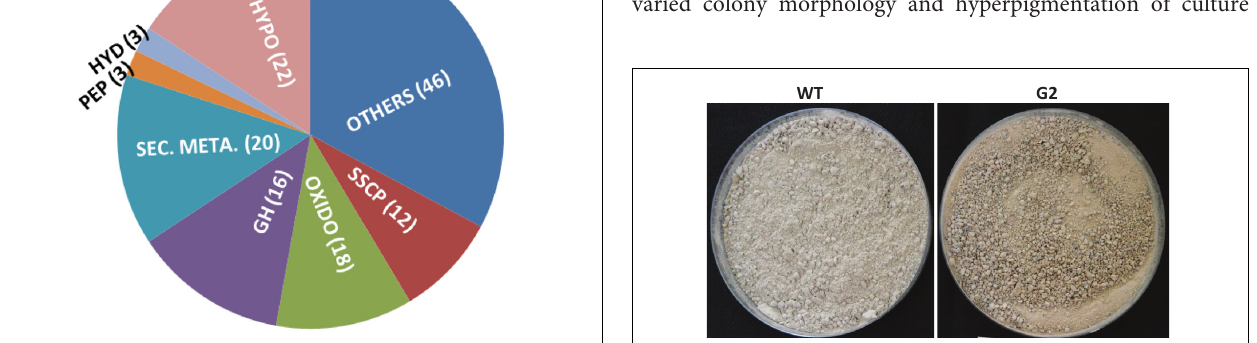
FIGURE 8 | Formulated product of Trichoderma virens wild type and mutant.